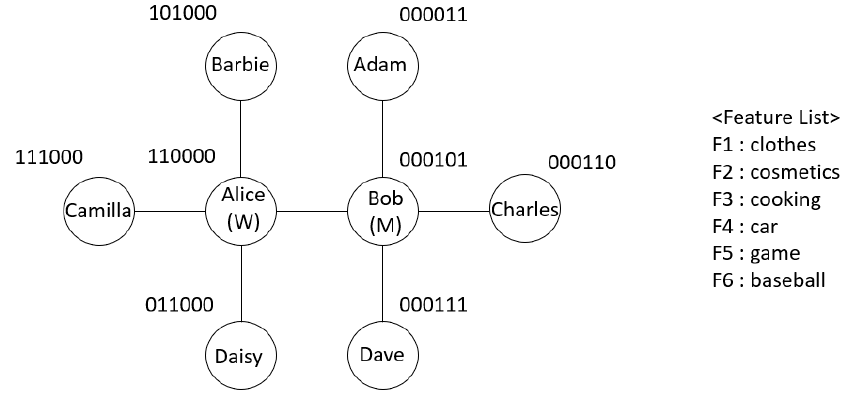
Figure 1. Graph Convolution Network (GCN) for Recommendation System.